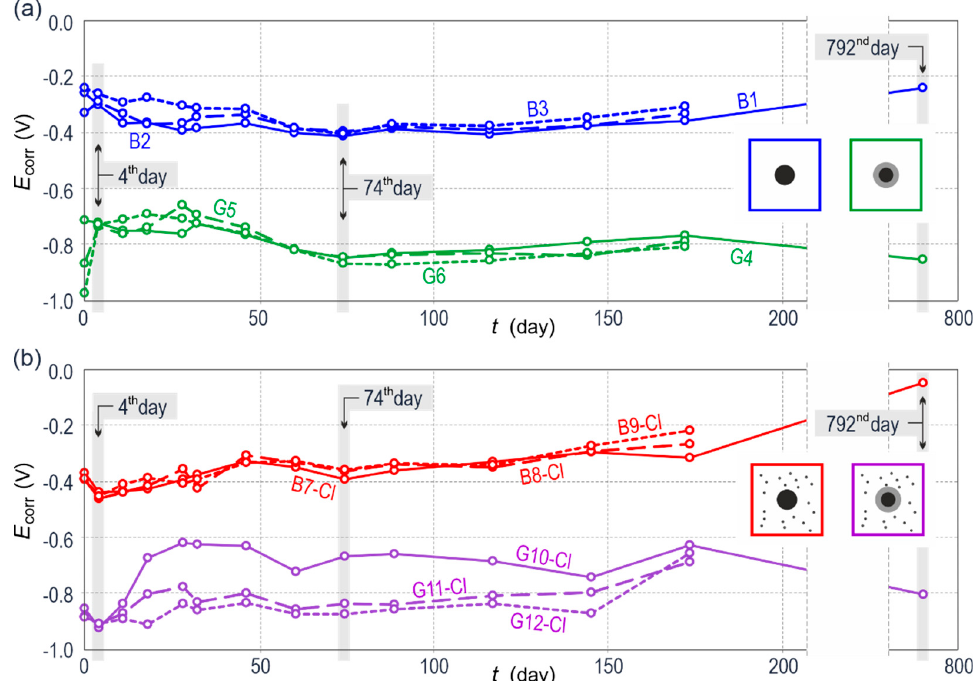
Figure 3. Changes in the function of time for corrosion potential E corr of galvanized and black steel reinforcement ( a ) in concrete without chlorides, ( b ) in concrete with chlorides; selected measuring series presented as diagrams and analyzed in details as part of electrochemical impedance spectroscopy (EIS) and linear polarization resistance (LPR) measurements are marked with grey color.